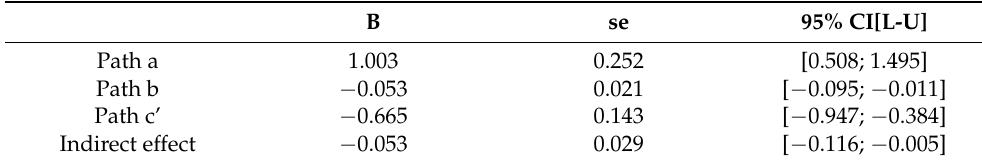
Figure 2. Mediation model. Table 3. Direct and indirect effects of employment condition on subjective well-being via future orientation.